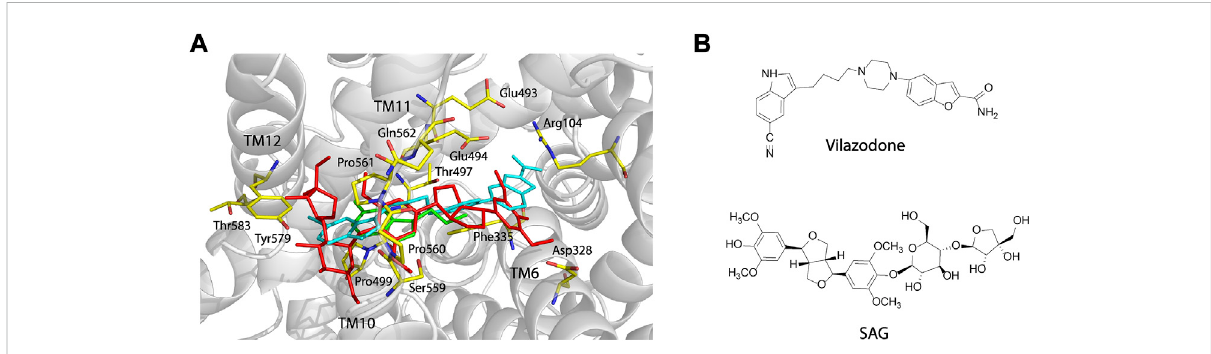
FIGURE 6 Comparison of the vilazodone binding pose with the binding poses for SAG and 5-HT within the S2 site and structures of vilazodone and SAG. (A) Comparison of the binding poses for vilazodone, SAG, and 5-HT within the S2 site. The main chain position of hSERT in the hSERT-imipramine- vilazodone complex structure (PDB ID, 7lWD) is shown in grey . Vilazodone, 5-HT (PDB ID, 7LIA), and SAG are shown in cyan , green , and red sticks , respectively. (B) Structures of vilazodone and SAG.